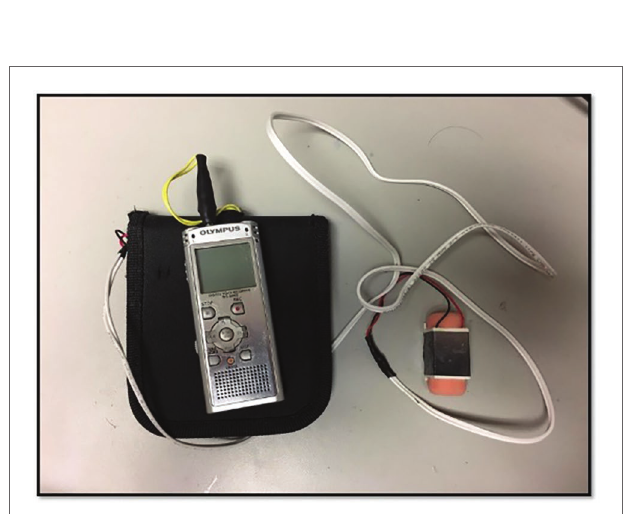
FIGURE 3 | Vibration apparatus. The audio player and amplifier (within black case) were stored in a backpack, and the tactor secured to the affected limb of the participant. Cabling was restrained using Coban wrap (3M, St. Paul, MN, United States) to prevent catching, ensuring there was no restriction to